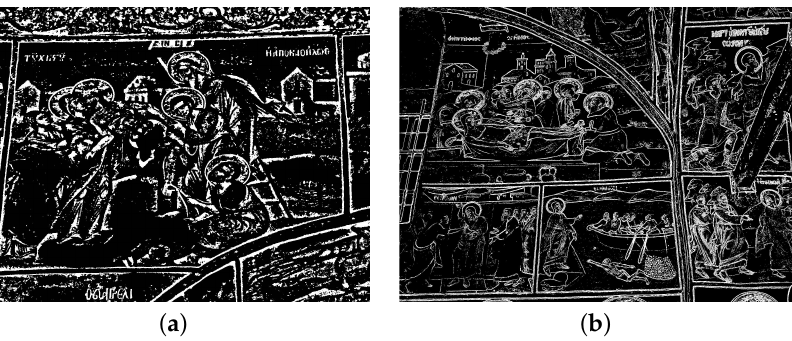
Figure 7. The Descent from the Cross from a church ( a ) Negades and ( b ) Tsepelovo, in Ioannina, Greece. Eventually, there are no certainties given the personal style of the painters, the area within the monument, and the condition of the painting. These are challenges that need to be addressed by the proposed